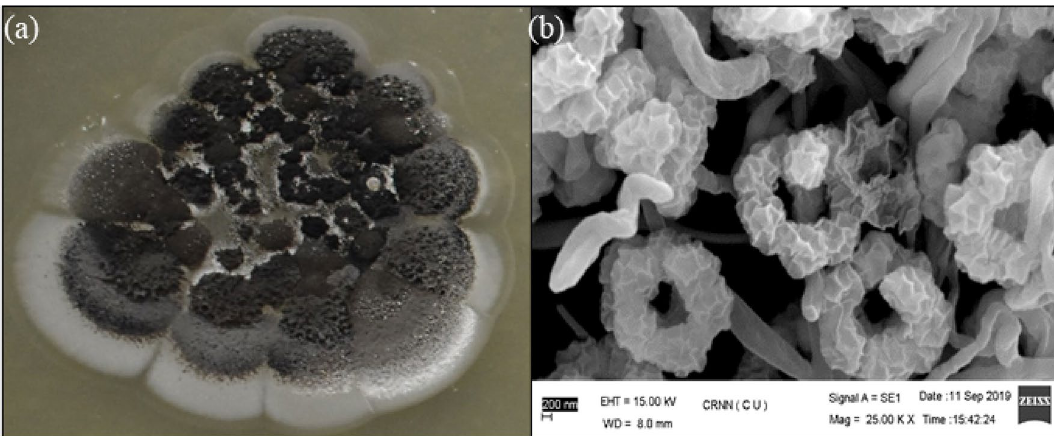
Figure 1. Morphology of the isolate PSAA01. ( a ) The colony morphology of the strain PSAA01; ( b ) the cell morphology of the filamentous actinomycete strain PSAA01 as observed under scanning electron microscopy in 25000X